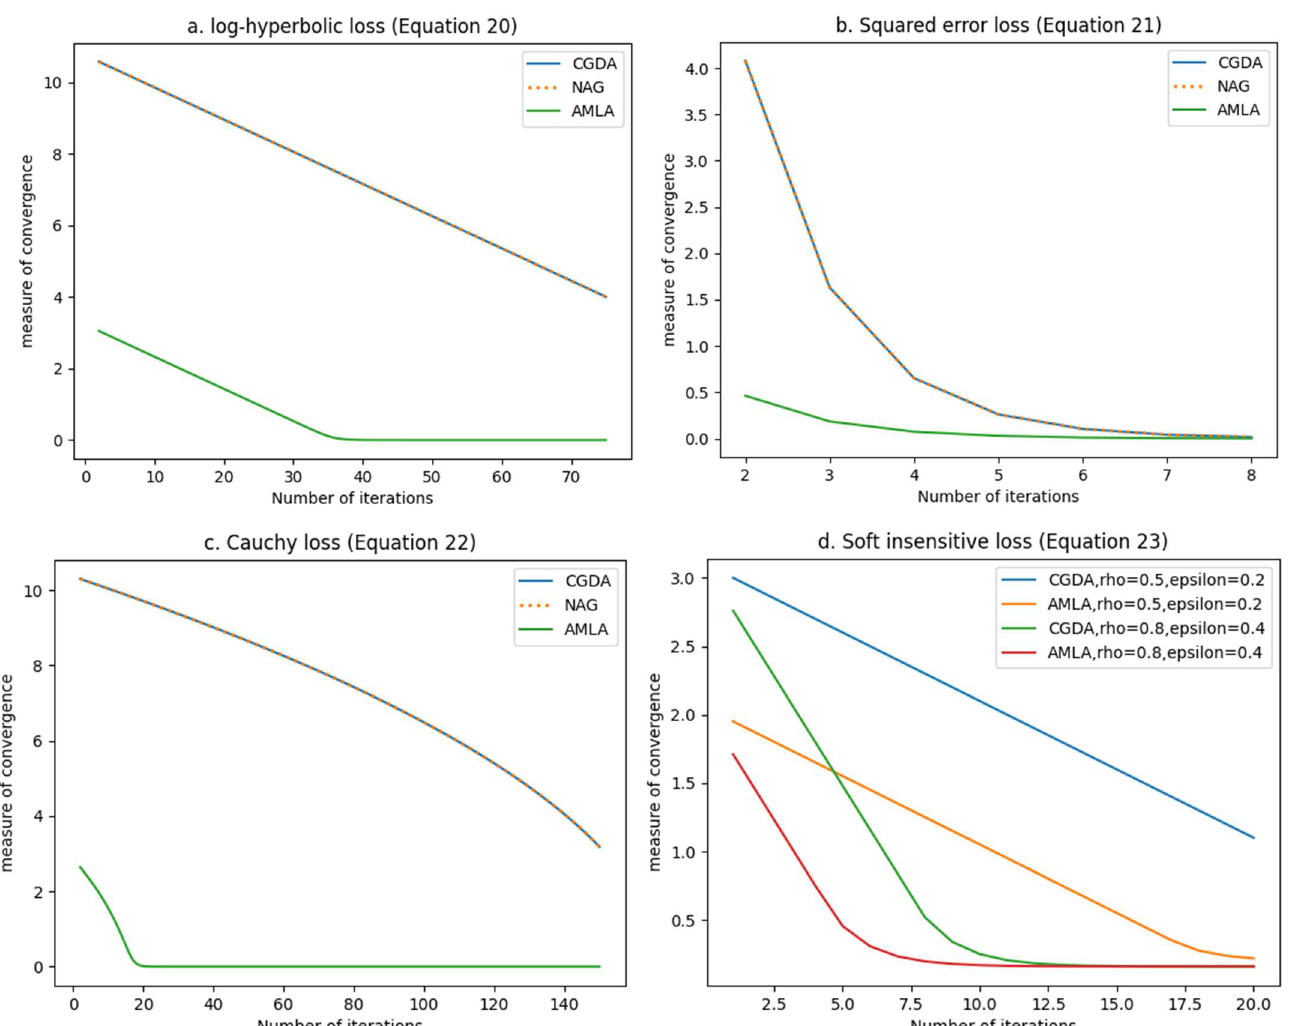
Figure 4. Comparison of the algorithmic efficiency of AMLA, NAG, and CGDA in approximating solutions for ( a ) log-hyperbolic loss (Equation (20)), ( b ) squared error loss (Equation (21)), ( c ) Cauchy loss (Equation (22)), and ( d ) 𝜺 -insensitive loss (Equation (23))